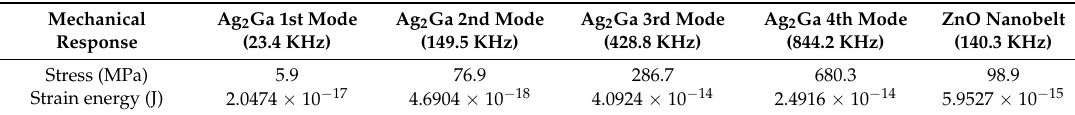
Table 3. The mechanical response of the Ag 2 Ga nanowire and Zno nanobelt from a thermoacoustic model. Mechanical